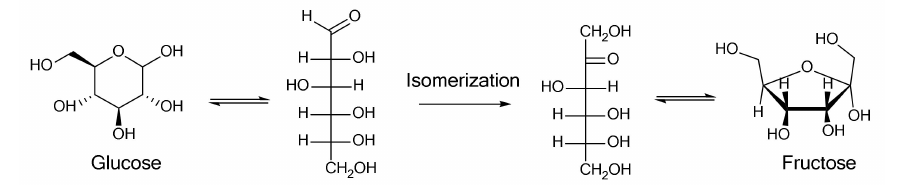
Figure 7. Schematic illustration for isomerization of glucose to fructose.